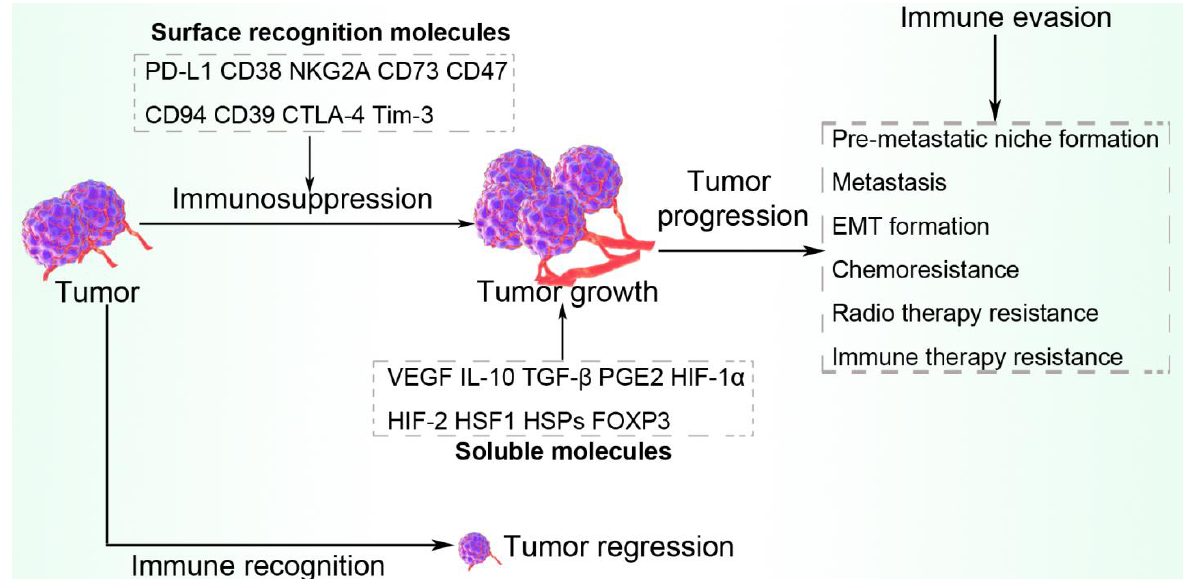
Figure 6. Hypoxic exosome-induced surface recognition molecules and soluble factors. Exosomes produced in the hypoxic TME enhance the expression of both surface recognition molecules and soluble factors that together promote tumor immune evasion. The exosomes either carry these molecules as packages or trigger their production via their regulatory activities. Tumors that undergo immune recognition gradually decrease in size while immune evasion causes increased tumor size and progression.